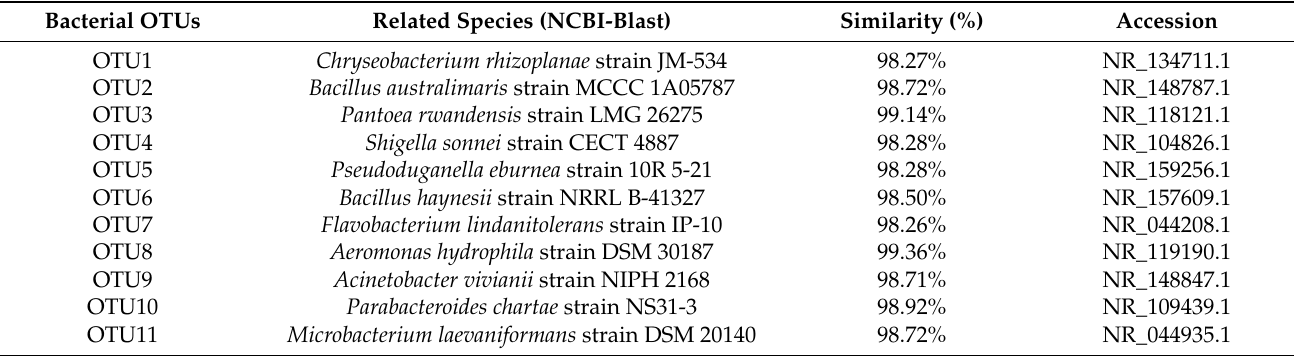
Figure 4. A probiotic heatmap showing the distribution of the 35 dominant OTUs based on the abundance of 16S rRNA gene sequences (≥10 sequences) from leaf samples of lettuce grown in Bacillus treated and control aquaponic systems. Each column in the heatmap represents a sample and each row represents an OTU. The relative colour code refers to sequence abundance, with high abundances (red colours) and low abundances (blue colours). Taxonomy (right column) indicates the phylum, order, family, and genus of each OTU. Table 5. The 35 dominant bacterial OTUs and their closest phylogenetic neighbours from lettuce leaf samples obtained from a small-scale coupled aquaponic system through BLAST searches.